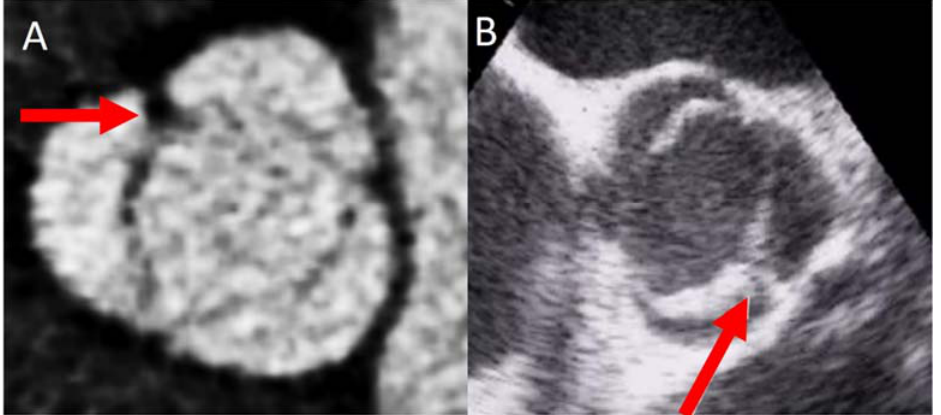
Figure 2. BAV with partial fusion (forma frustre). Arrows show the mini raphe by CT ( A ) and by TEE ( B ). TEE ( B